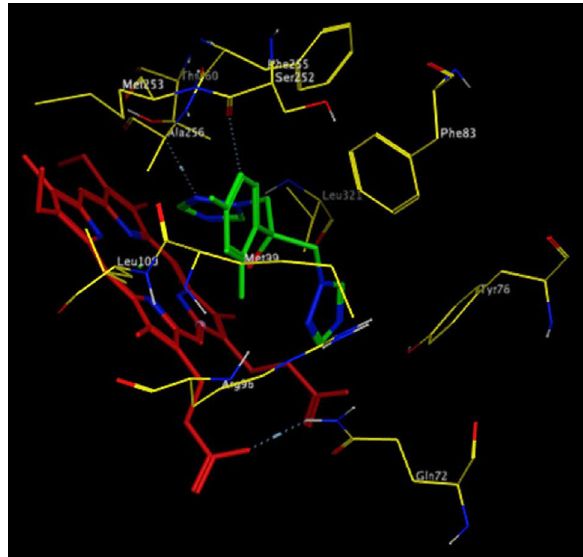
Figure 2. Docking conformation of fluconazole at the active site of Mycobacterium P450DM